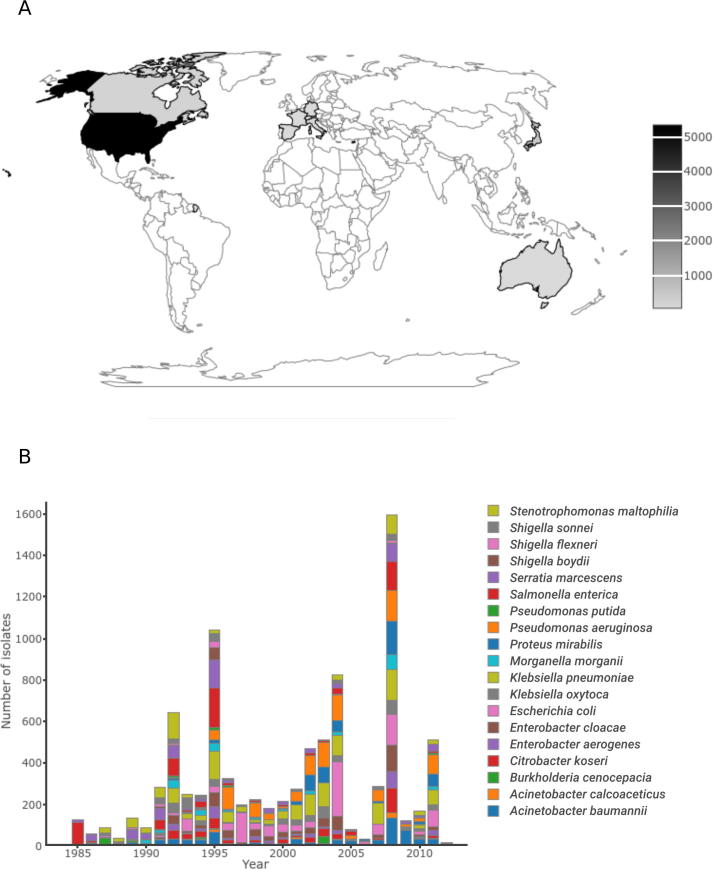
Local and temporal distribution of the bacterial isolates The numbers of bacterial isolates collected in different countries (A) and years (B) for species with at least 50 isolates.